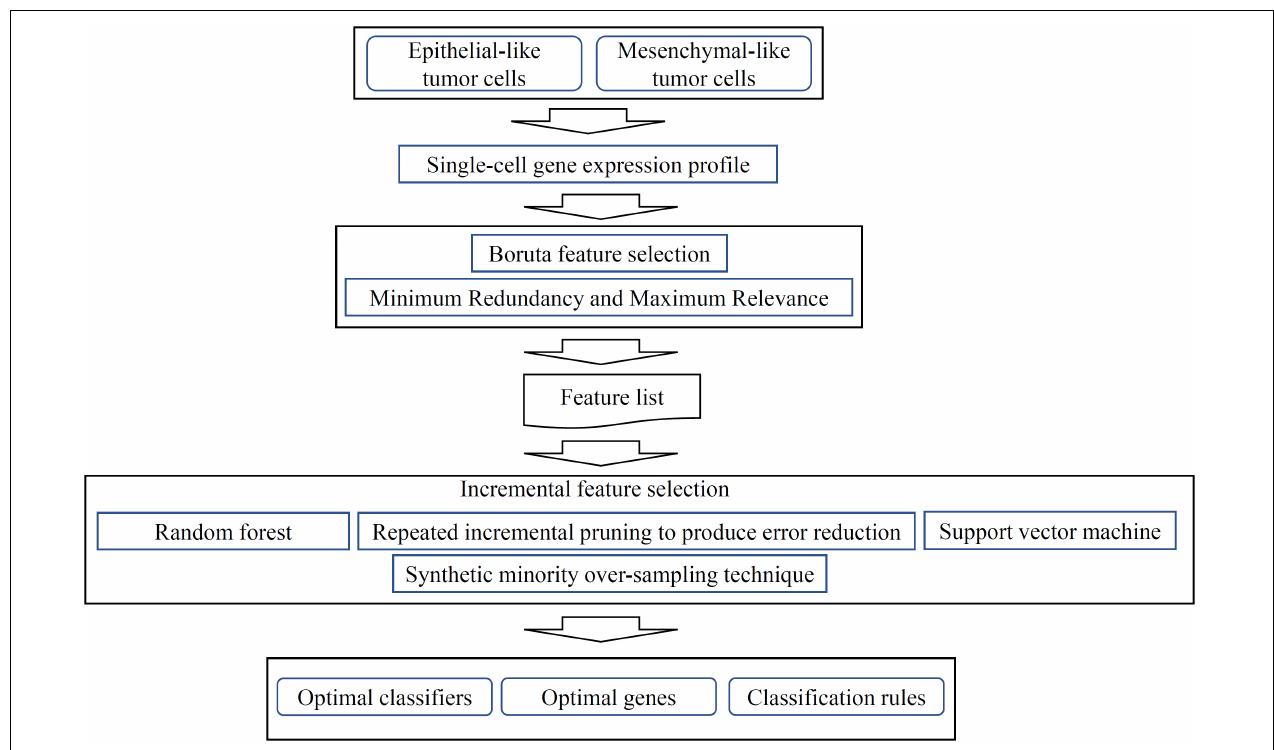
FIGURE 1 | Flow chart of computational analysis. A systematic workflow integrating feature selection, machine learning models, and rule learning was applied to identify potential biomarkers for distinguishing single-cell isolated tumor cells (TCs). Optimal classifiers, genes and rules were identified based on the performance of different machine learning, rule learning models and the importance of features in each